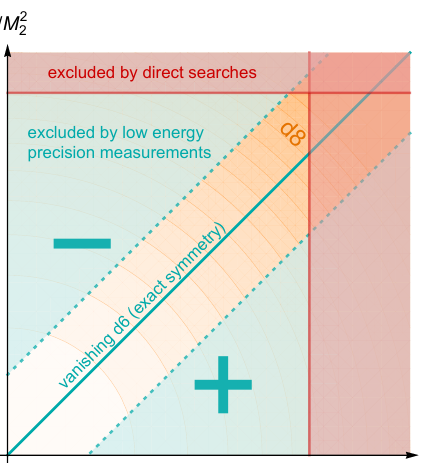
Figure 2 . A schematic plot on the interplay between precision measurements and direct searches. For simplicity, we assume only two new particles X 1 and X 2 with masses M 1 and M 2 and some universal couplings to SM. They each contribute to one of the cross sections in the sum rule, with σ ( ab → X 1 ) and σ ( a ¯ b → X 2 ) . The symmetry in eq. (4.2) corresponds to the diagonal line, where the contribution to A ( ab → ab ) from dimension-6 operators vanishes, while the plus (minus) sign denotes the region in which this contribution is positive (negative). Contributions to A ( ab → ab ) from dimension-8 operators are proportional to 1 tions to ˜ A ( ab → ab ) from dimension-8 operators are proportional to 1 by the orange circular contours in figure 2. Near the region M